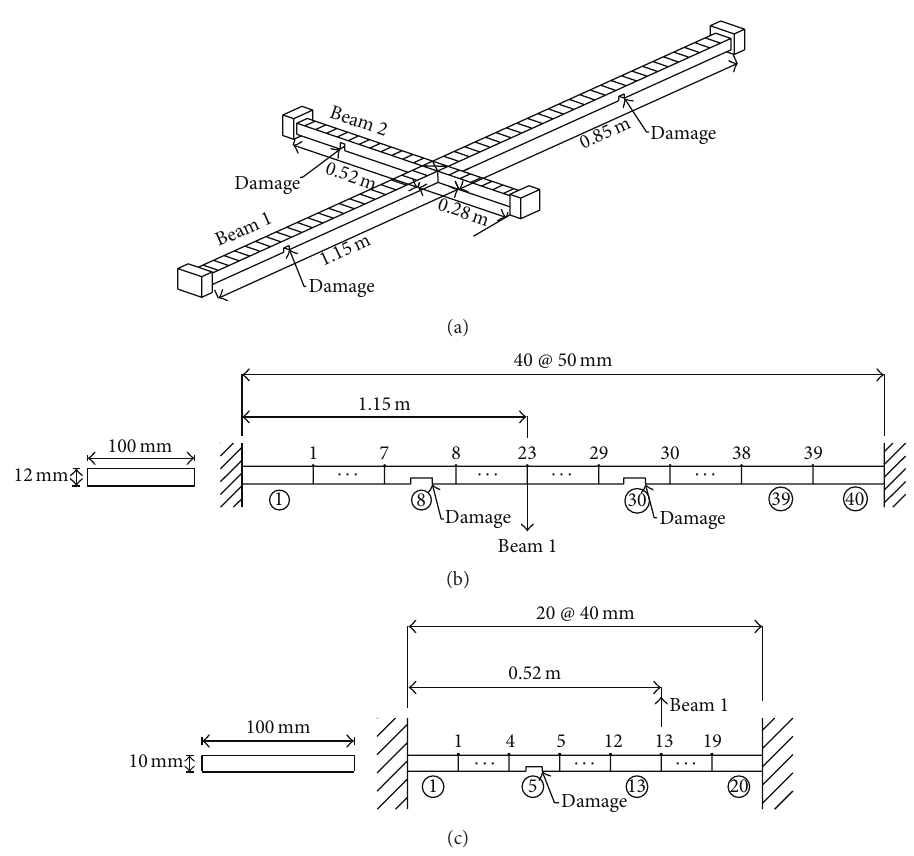
Figure 8: A crossed-beam structure: (a) a beam structure, (b) finite elements of beam 1, and (c) finite elements of beam 2.